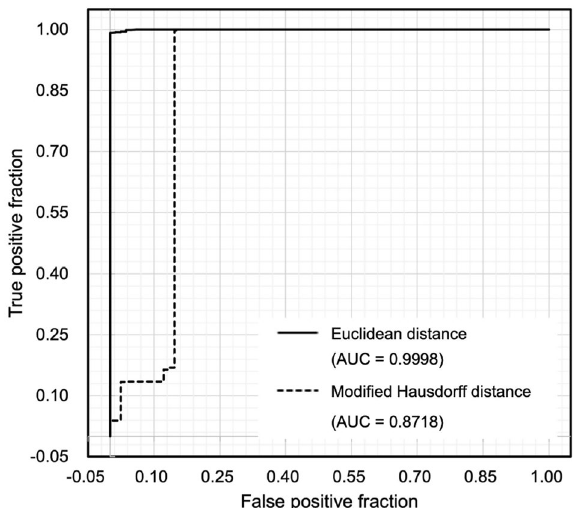
Figure 3. ROC curve of Euclidean distance of modified Hausdorff